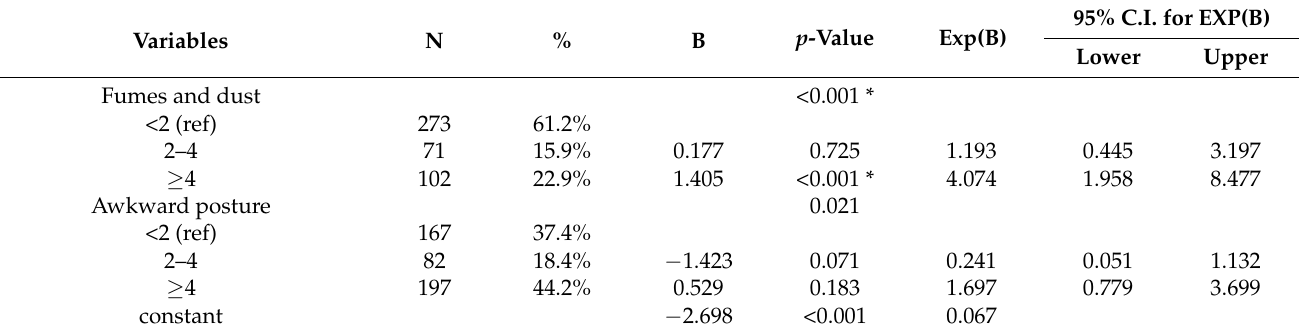
Table 14. Results of logistic regression on lower limb pain.